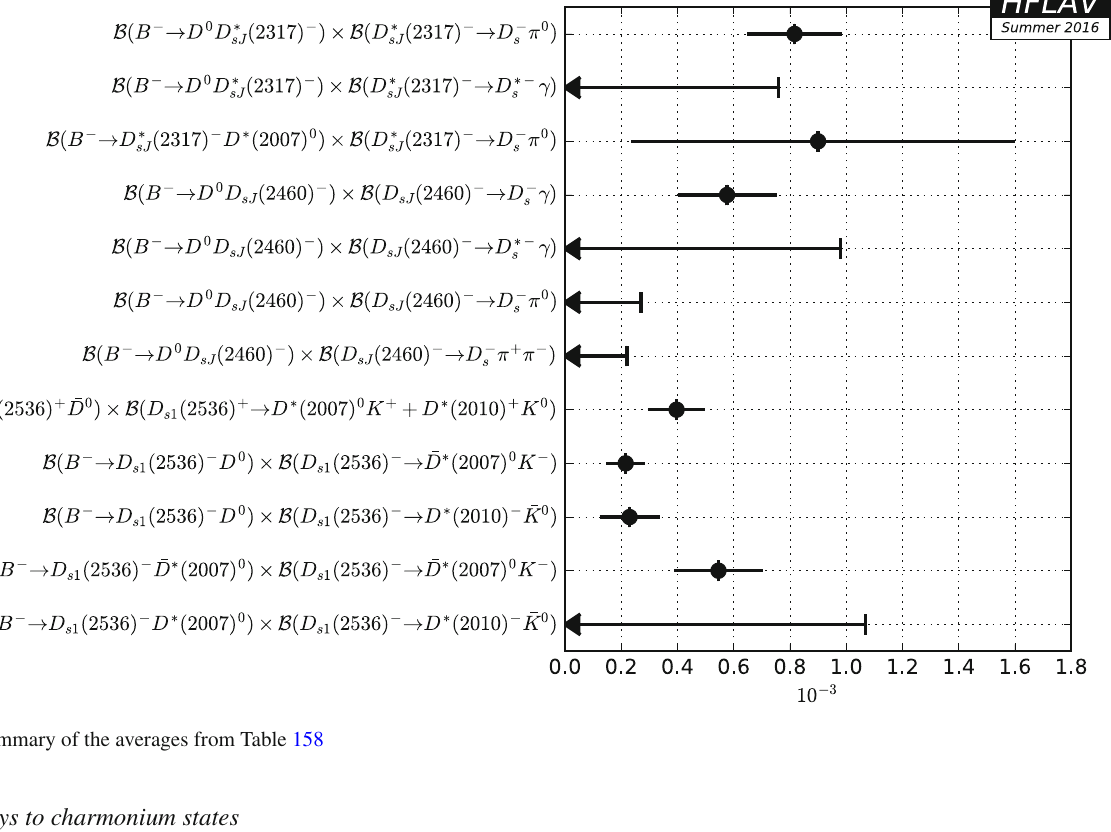
Fig. 127 Summary of the averages from Table 158